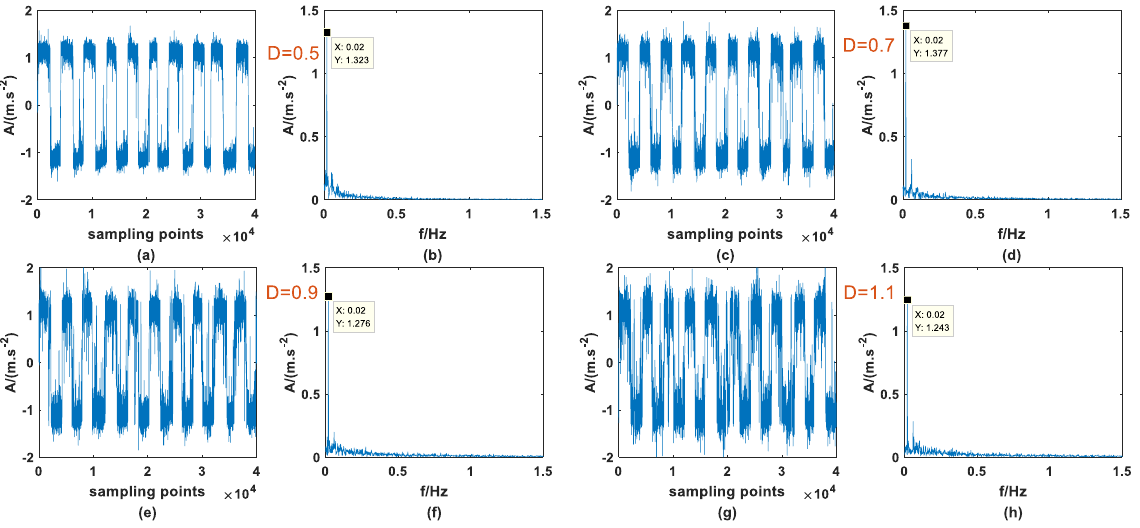
Figure 14. Output signal with AWGN of different D ( a ) time domain ( D = 0.5), ( b ) frequency domain ( D = 0.5), ( c ) time domain ( D = 0.7), ( d ) frequency domain ( D = 0.7), ( e ) time domain ( D = 0.9), ( f ) frequency domain ( D = 0.9), ( g ) time domain ( D = 1.1), ( h ) frequency domain ( D = 1.1).